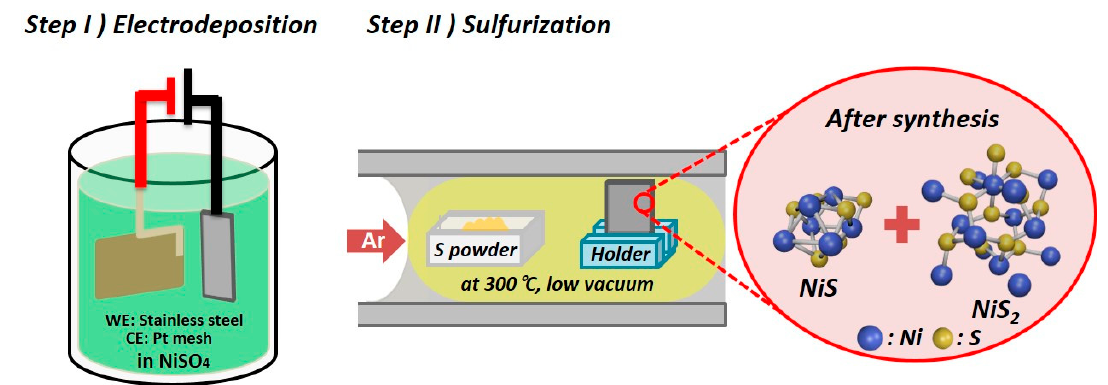
Figure 1. Schematic illustration of two-step sample preparation. Step (1) nickel electrodeposition in 1 M nickel sulfate solution and step (2) sulfurization for NiS x /SUS at 300 °C for 30 min.